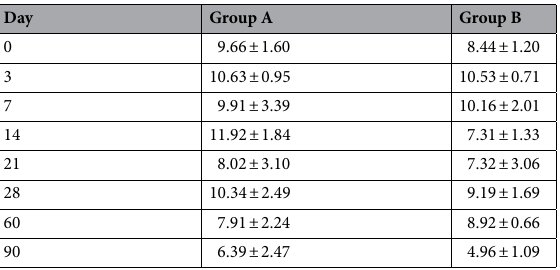
Table 2. Mean concentrations of ziv-aflibercept (ng/mL) at each time point (mean ± SD, N = 64). Anti-VEGF quantification (ng) of ziv-aflibercept was based on a standard curve. The expected concentration was 10 ± 2 ng/ mL, according to the initial concentration and subsequent dilutions. Statistical analysis was performed comparing the samples at each time point to the baseline at day 0 and between groups. All comparisons within groups, p value- > 0.05, and between groups, p value- >